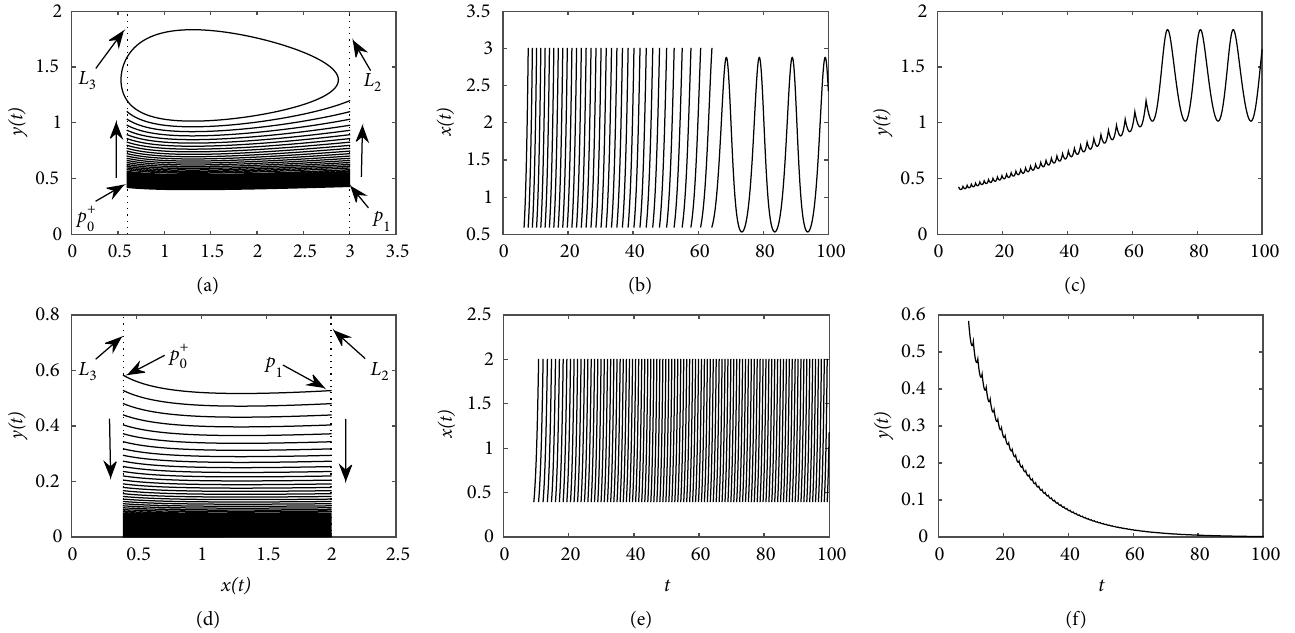
and 퐴 𝑙 = 0.02643